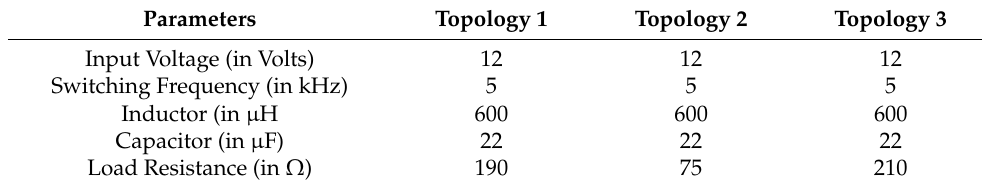
Table 4. Parameter values used for simulation.